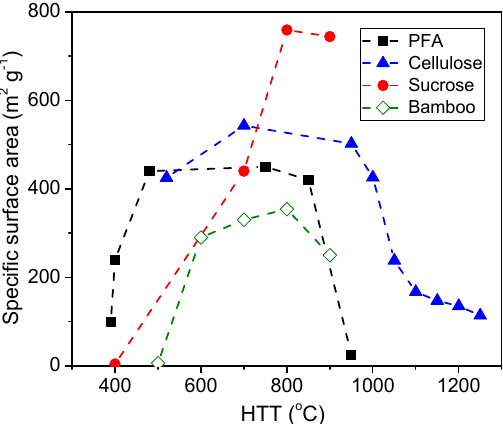
Figure 3. The variation of specific surface area with HTT for the carbonization of polyfurfuryl alcohol (PFA, reproduced from [28] with permission from Elsevier, © 1964), sucrose (reproduced from [29] with permission from Elsevier © 2014), bamboo (reproduced from [30] with permission from Elsevier © 2014) and cellulose.